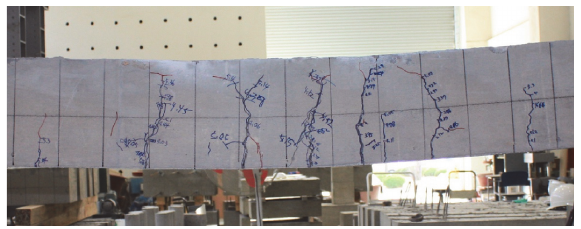
Figure 8: Specimen failure